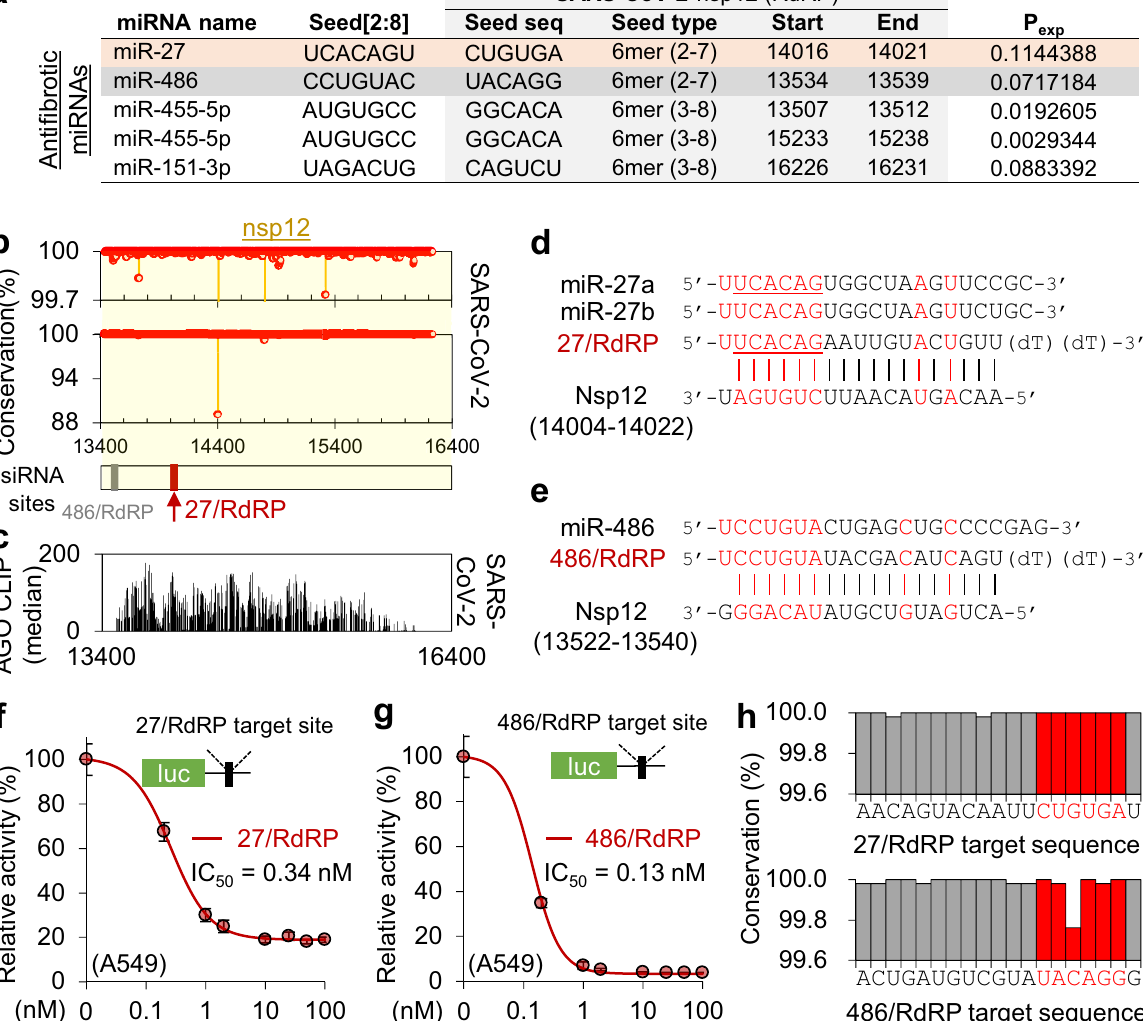
(Fig. 4d,e). Additionally, predominant downregulation of putative miR-27 targets (seed sites in 3 ′ UTRs) in DEGs depending on 27/RdRP or miR-27a expression (Fig. 4b,e) reflects primary effects as miR-27 targets, in contrast to upregulated DEGs which may reflect the secondary effect from target repression. The consensus secondary effect, that overlaps between 27/RdRP and miR-27a, could be examined in part as only looking at overlapping downregulation and their gene ontologies. These results demonstrated that siRNAs targeting SARS-CoV-2 could direct the miRNA-like off-target effects to the way that could potentially suppress pro-fibrotic pathways by